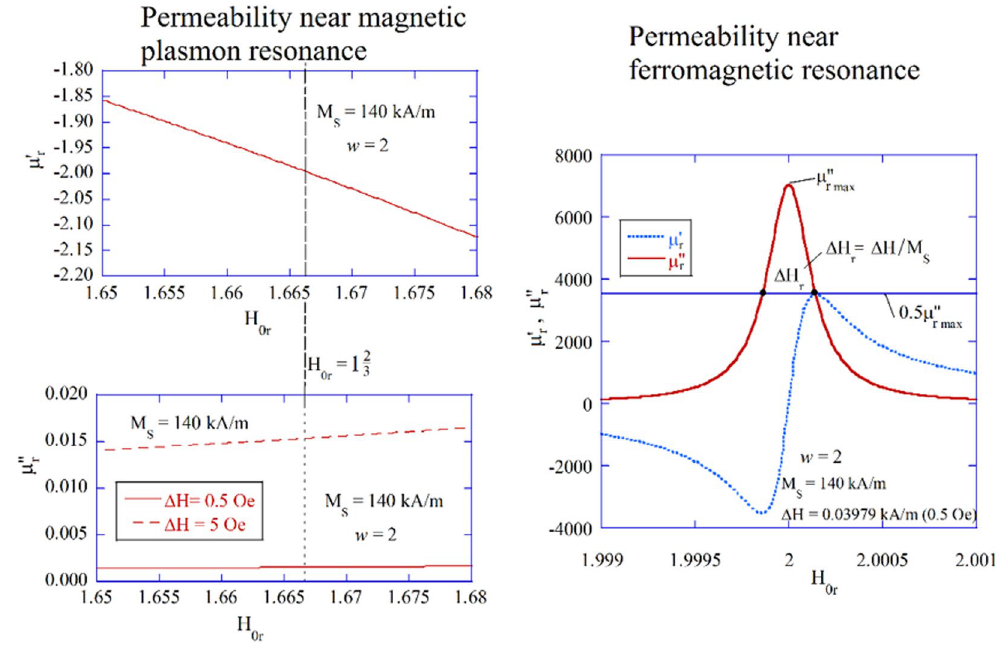
Figure 1. Permeability. The real and imaginary components of the complex scalar relative permeability = μ + κ in the vicinity of the MPR (on the left) and FMR (on the μ r